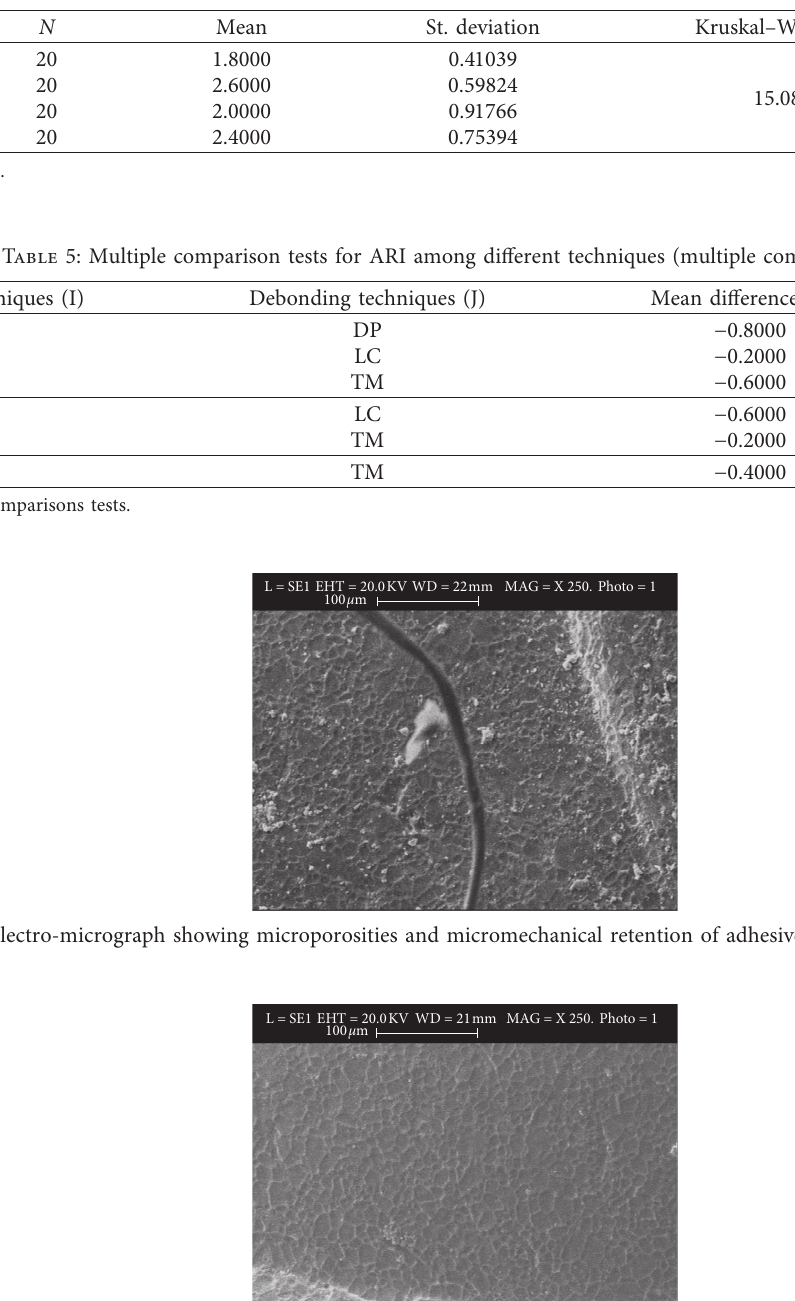
Table 4: Mean Adhesive Remnant Index among the different debonding techniques.